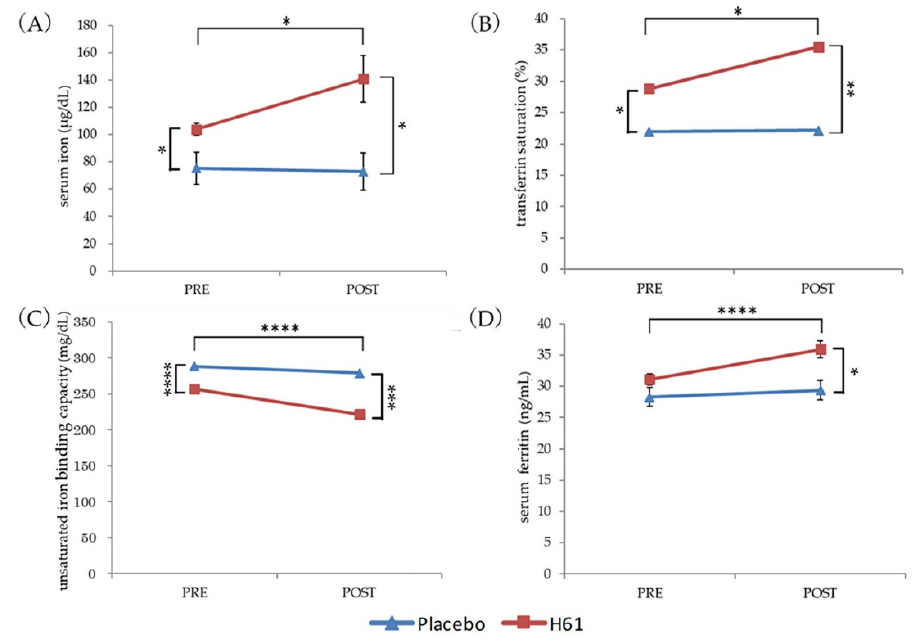
Figure 2. Changes in hematological parameters. ( A ) Serum iron. ( B ) Transferrin saturation. ( C ) Un- saturated iron-binding capacity. ( D ) Serum ferritin. * p < 0.05, ** p < 0.01, *** p < 0.005, **** p < 0.001. Iron status, depending on menstrual cycle (follicular phase vs. luteal phase), was also examined. Ferritin was significantly higher ( p < 0.05) in the follicular phase (EMM 33.9, SE 1.0 ng/mL) than in the luteal phase (EMM, 28.5; SE, 1.2 ng/mL). There were no significant differences in other parameters, such as serum iron and TSAT (Supplementary Table